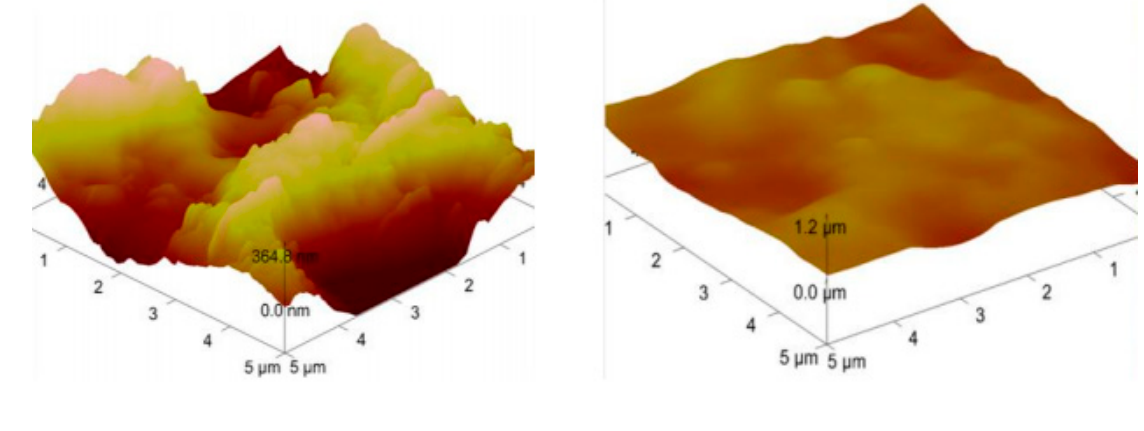
Figure 2 . AFM (Atomic Force Microscope) imaging of MIP and NIP after imprinting with